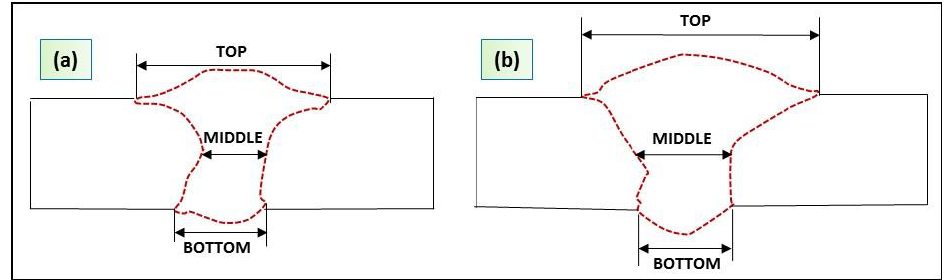
Figure 8. Weld cross section sketches: ( a ) DP-AISI 316 and ( b ) TWIP-AISI 316.